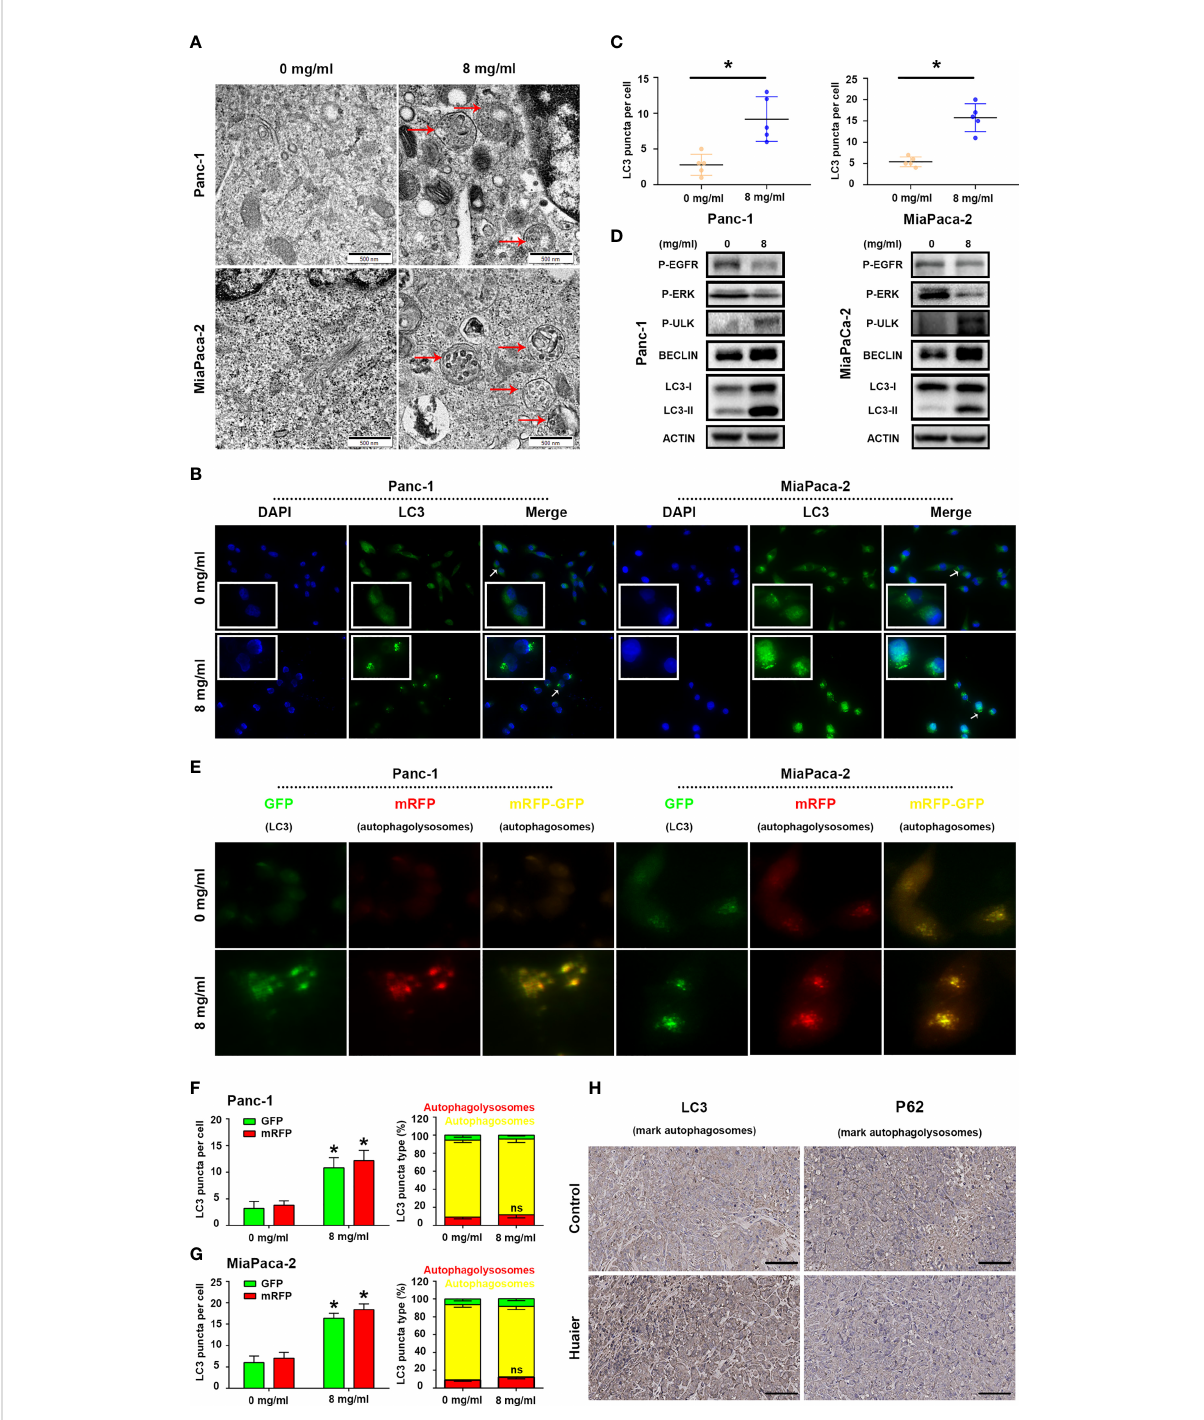
FIGURE 4 Huaier induced autophagy in pancreatic cancer. (A) TEM images showing autophagosomes (red arrows) in the Panc-1 and MiaPaCa-2 cells after the Huaier treatment. (B, C) Immuno fl uorescence staining of LC3 puncta (white arrows) and statistical analysis of the Panc-1 and MiaPaCa-2 cells after Huaier treatment. (D) Western blotting showing the protein levels of P ‐ EGFR, P-ERK, P-ULK, BECLIN and LC3 in Panc-1 and MiaPaCa- 2 cells after Huaier treatment. (E – G) ad-mRFP-GFP-LC3-based fl uorescence images of autophagosomes (yellow) and autophagolysosomes (red) and their statistical analysis in Panc-1 and MiaPaCa-2 cells after Huaier treatment. (H) IHC staining of LC3 and P62 showing the autophagy status of pancreatic cancer tumours in the control and Huaier groups. *P < 0.05, scale bar = 100 m